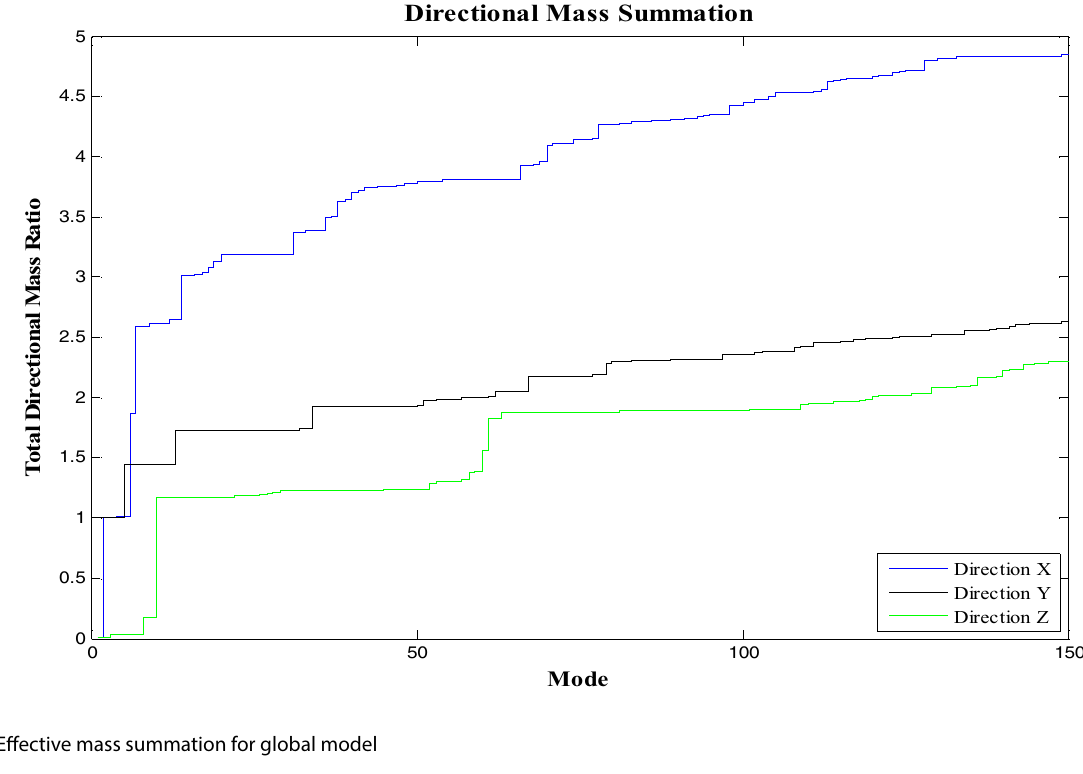
Fig. 5 Effective mass summation for global model